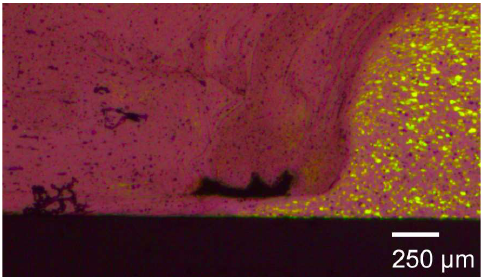
Figure 8. Defect detail generated in the specimen FSW-WS = 8-AA7050-R.